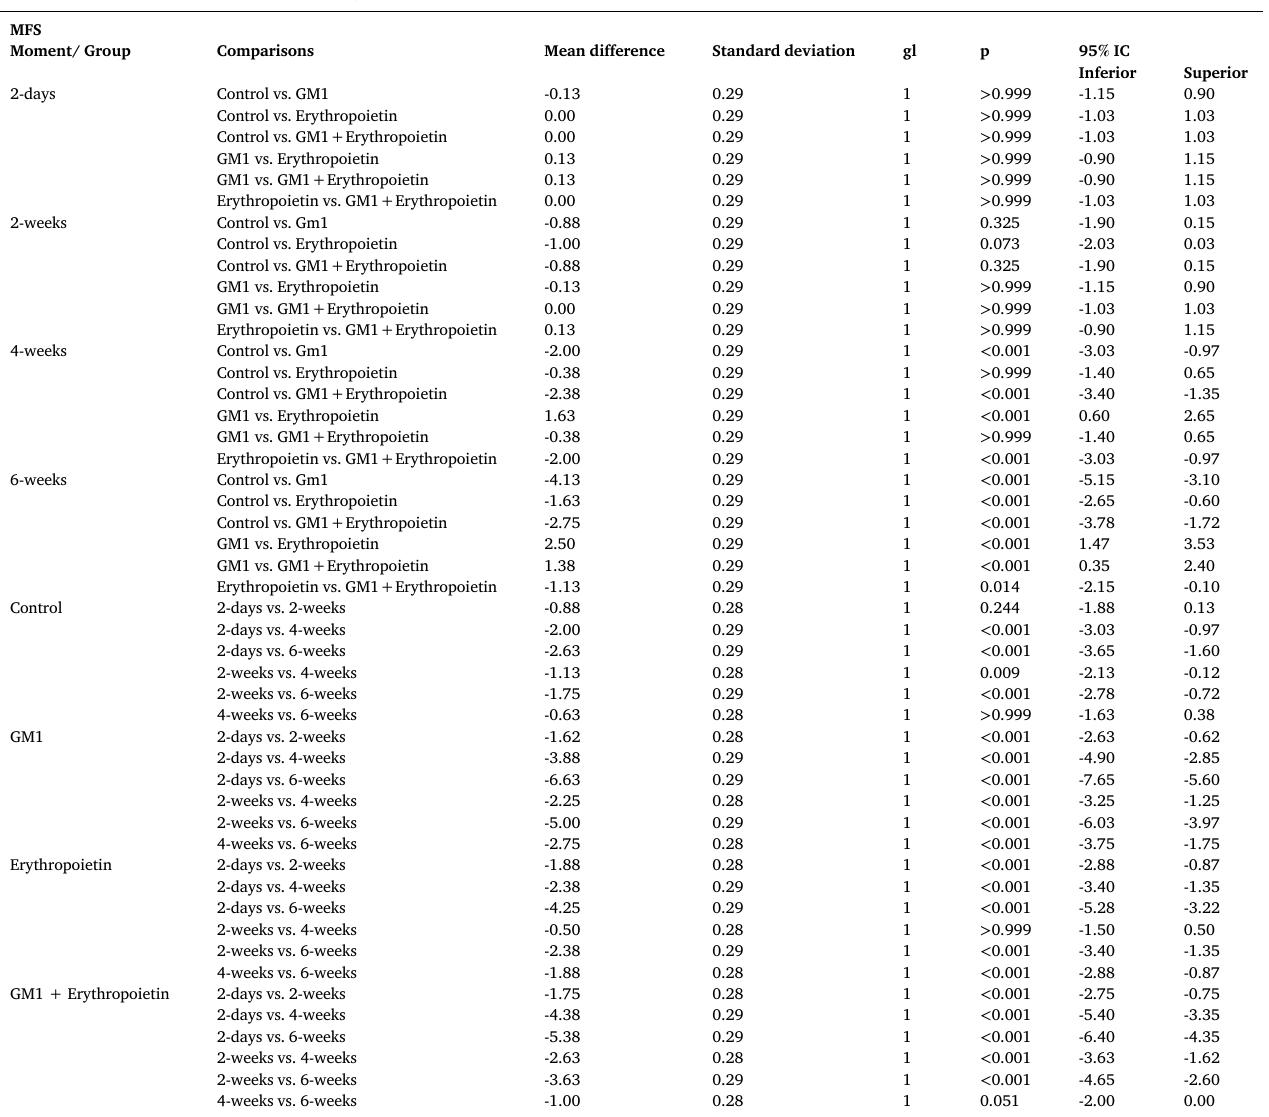
Table 4 Result of multiple MFS scale comparisons per group and assessment time point. MFS Moment/